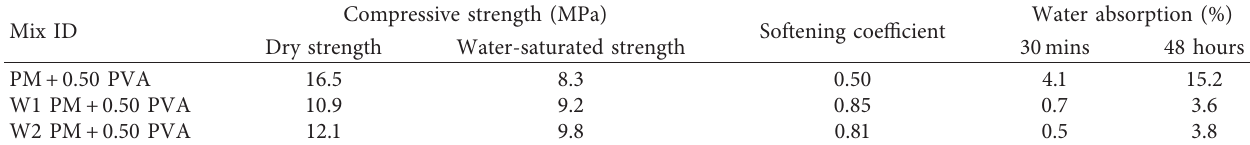
Table 4: Compressive strength, softening coefficient, and water absorption of LCC with water repellent